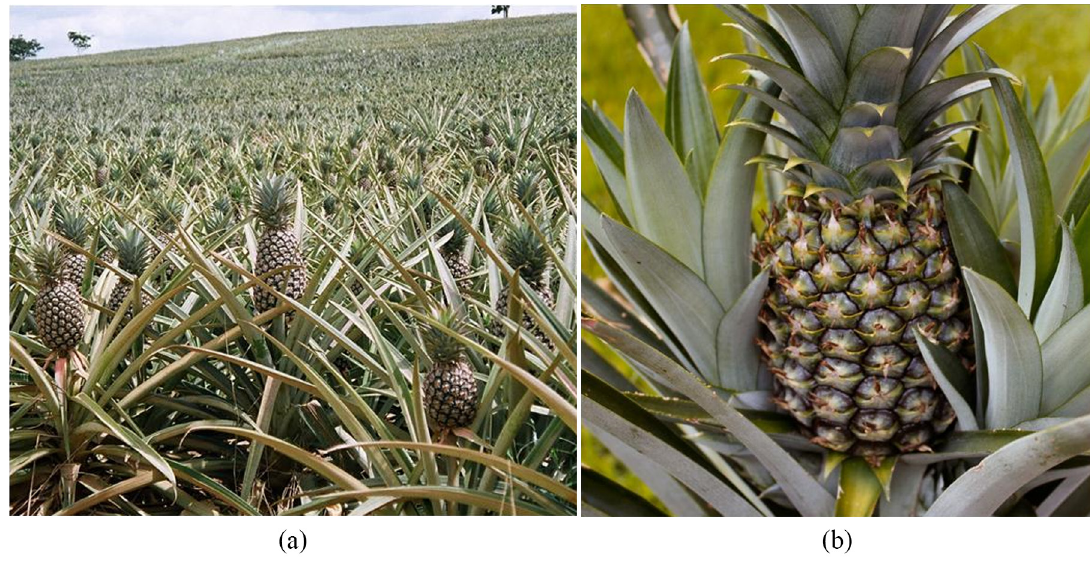
Figure 2. Pineapple plantation (a) and fruit with leaves